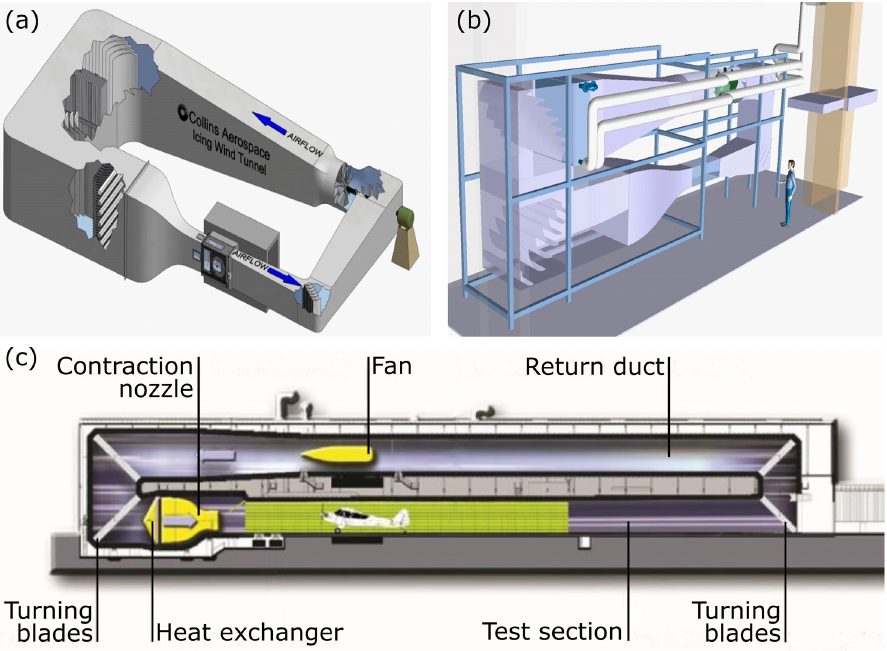
Figure 2. Schematics of the IWTs that were used for the measurements: (a) Goodrich IWT of Collins Aerospace (image modified from Collins Aerospace, 2021), (b) Braunschweig Icing Wind Tunnel of the Technical University of Braunschweig (figure source: Institute of Fluid Mechanics of TU Braunschweig) and (c) Climatic Wind Tunnel of Rail Tec Arsenal (image modified from Rail Tec Arsenal, 2022). Table 1. Specifications of the IWTs that were used for the measurements. IWT Test section size Temperature range Airspeed (L × W ×